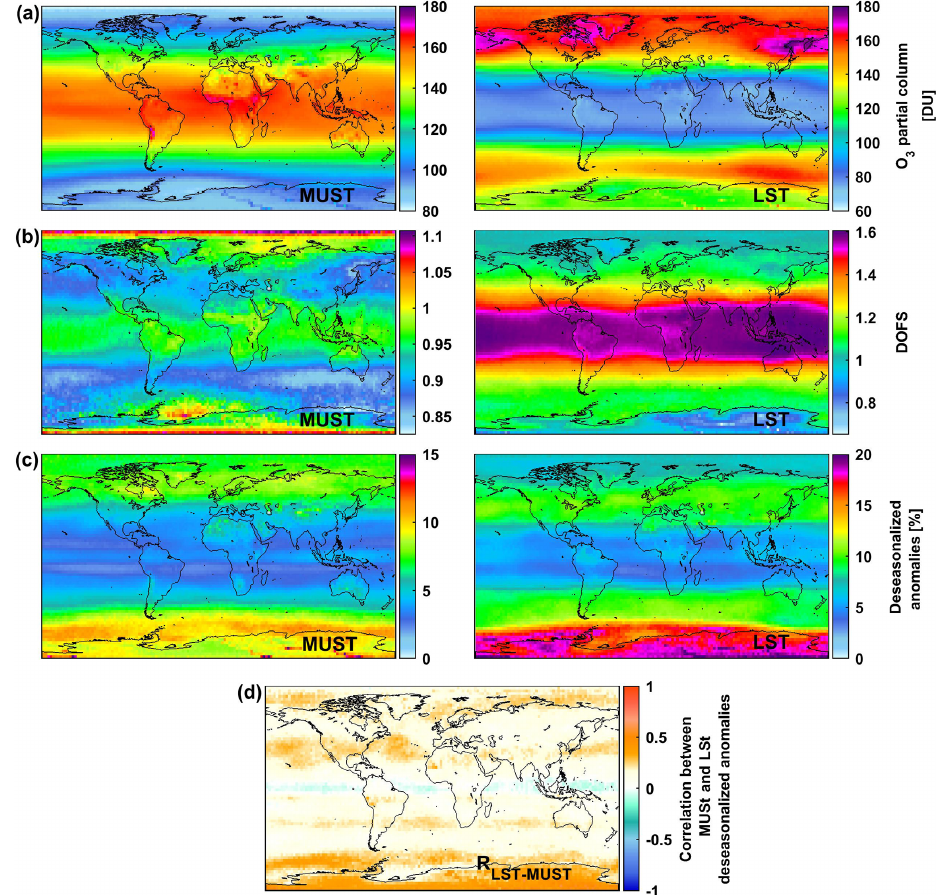
Figure 1. Global distribution of (a) daily O 3 columns (in Dobson units – DU), (b) associated DOFS, (c) absolute deseasonalized anomalies (in percentage) averaged over January 2008–December 2017 in the MUSt (middle–upper stratosphere: > 25hPa; left panels) and in the LSt (lower stratosphere: 150–25hPa; right panels). Panel (d) shows the correlation coefficients between the daily O 3 deseasonalized anomalies in the MUSt and in the LSt. Note that the scales are different between MUSt and